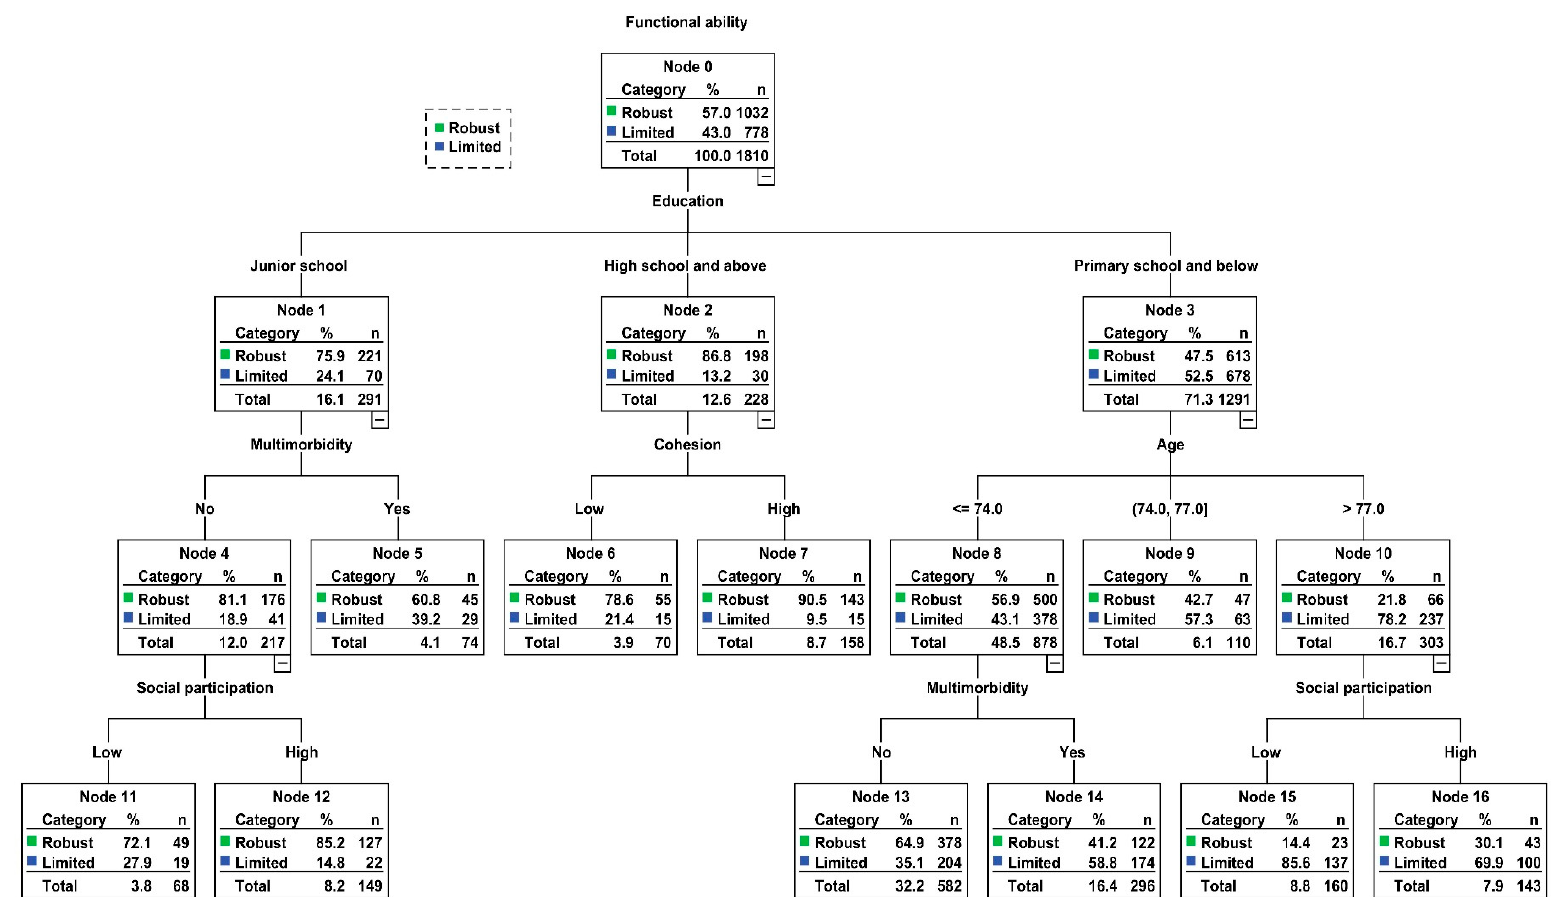
Figure 1. Classification and regression tree model (N = 1810).